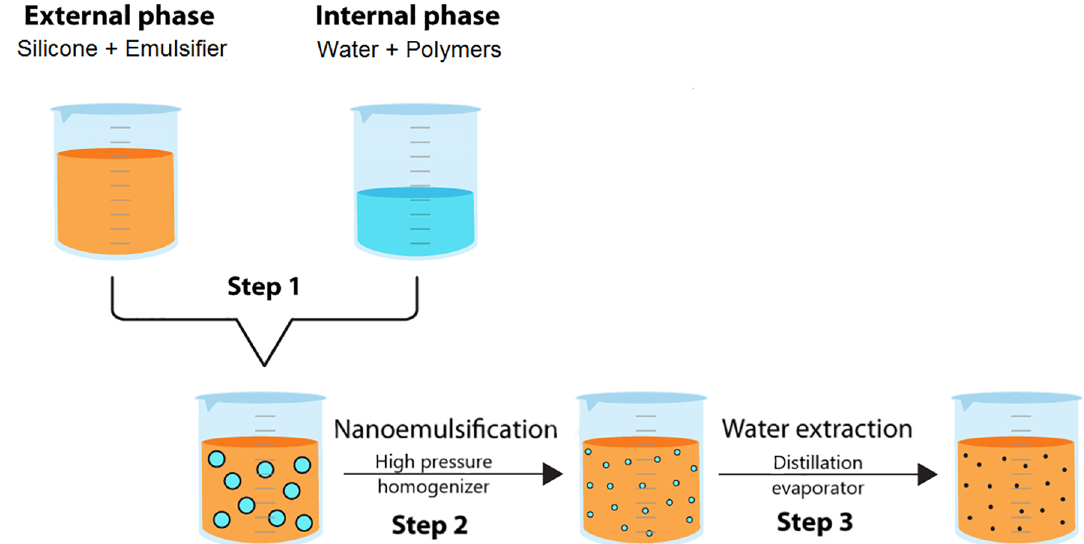
Figure 1. Preparation process of Polymeric Colloidal Nanocarriers (adapted from N.N.P. Cerize, 2012 2